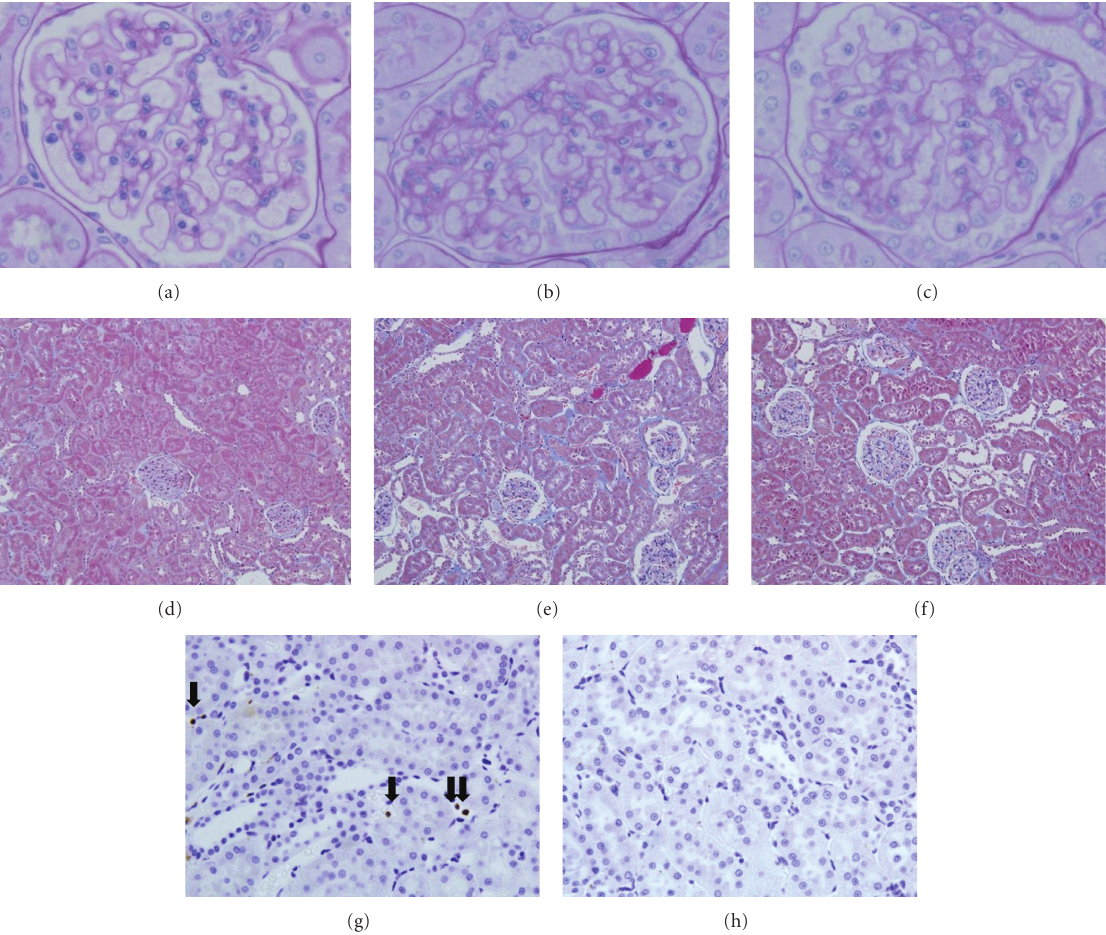
Figure 4: Glomerular sclerosis, tubulointerstitial fibrosis, and macrophage infiltration. PAS-stained (a)–(c), Masson trichrome-stained (d)– (f), or ED-1-immunostained (g) and (h) renal tissues. WKY rats (a), (d), MC/MF (c), (f), (h), and HC/LF (b), (e), (g) at the end of study. Arrows indicate ED-1 positive cells. Original magnification 400 × ((a)–(c), (g), (h)) and 200 × (d)–(f).